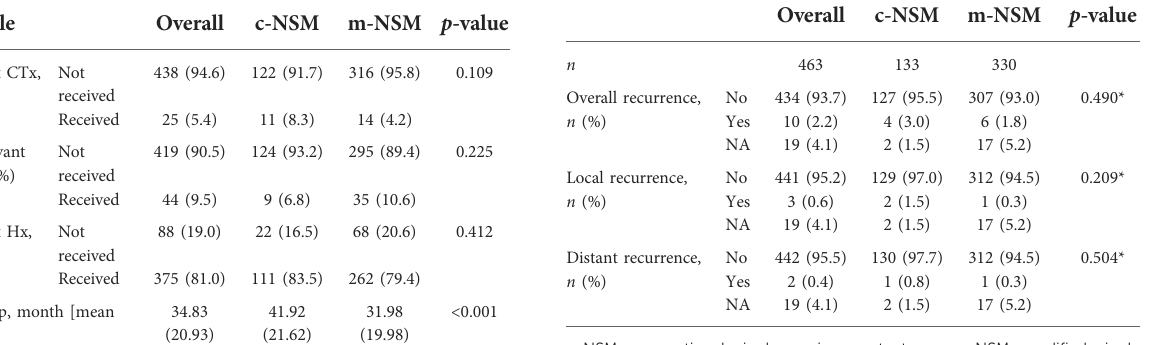
TABLE 3 Recurrence